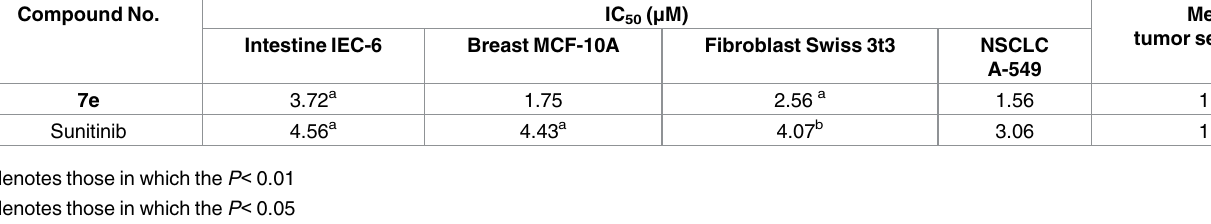
Table 4. Selectivity for compound 7e and sunitinib toward tumor and non-tumorigenic cell lines. Compound No.